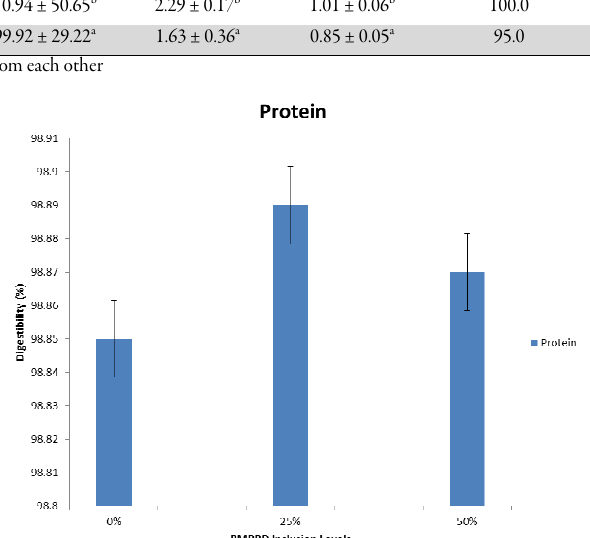
Table 4. Growth performance of the cultured fish fed different experimental diets BMBRD inclusion level